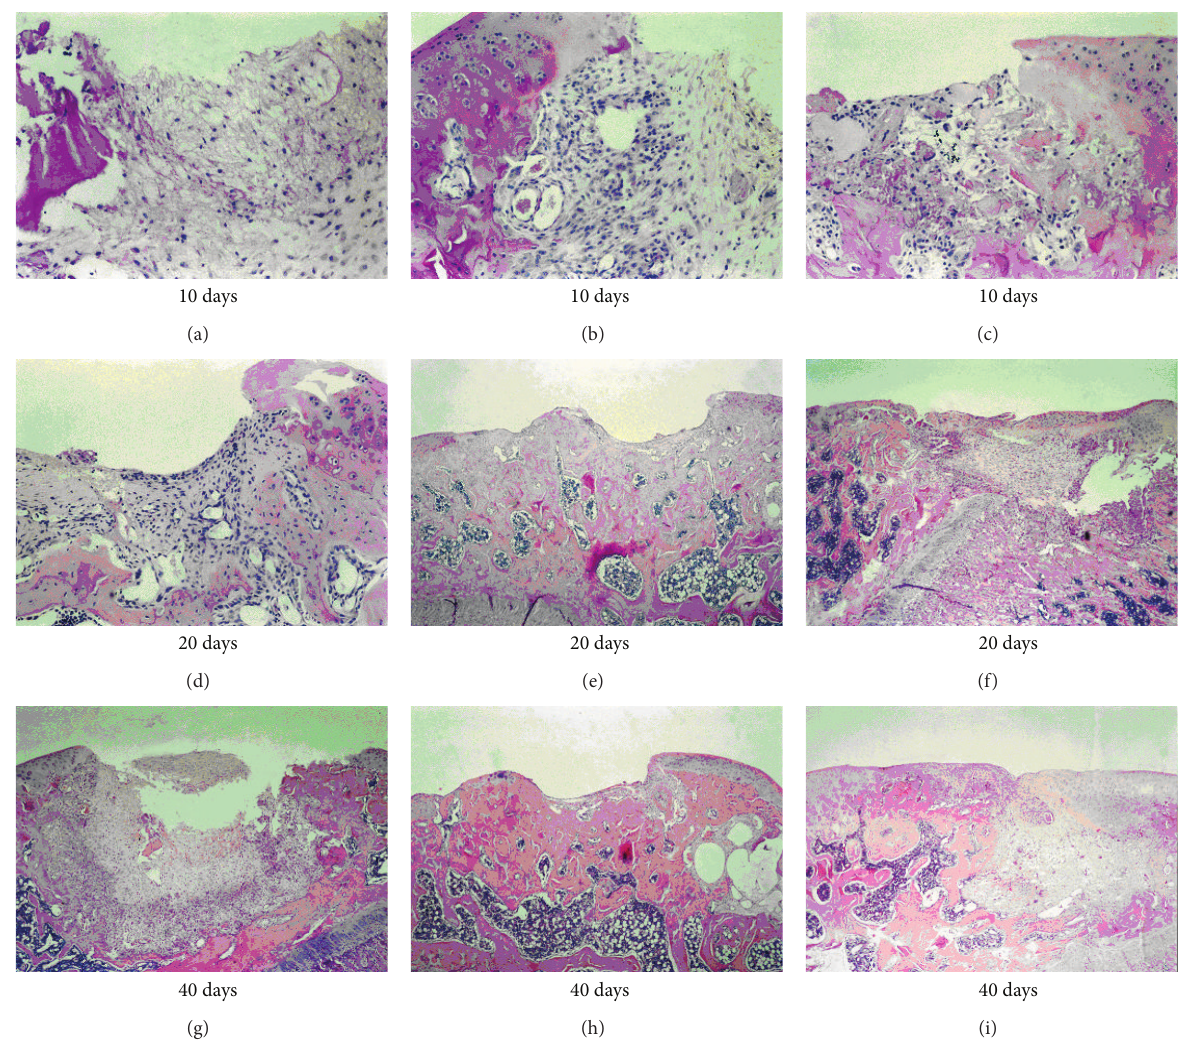
Figure 1: The results of specimen HE staining in restoration area; magnification times of all pictures in Figure 1 are 200. Pictures (a), (d), and (g) belong to group A; pictures (b), (e), and (h) belong to group B; pictures (c), (f), and (i) belong to group C.